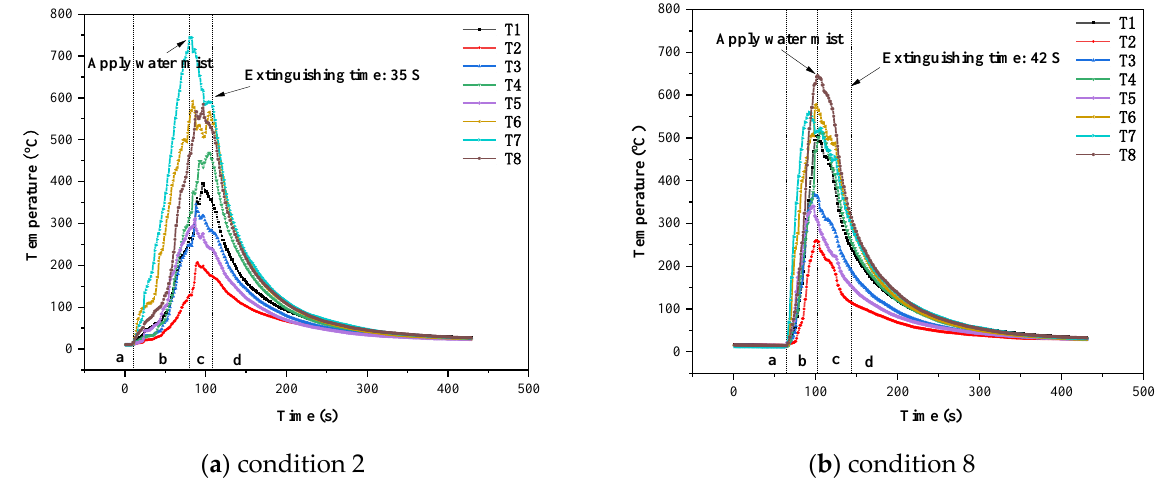
Figure 7. Temperature curve of flame thermocouple under test conditions 2 and 8 .